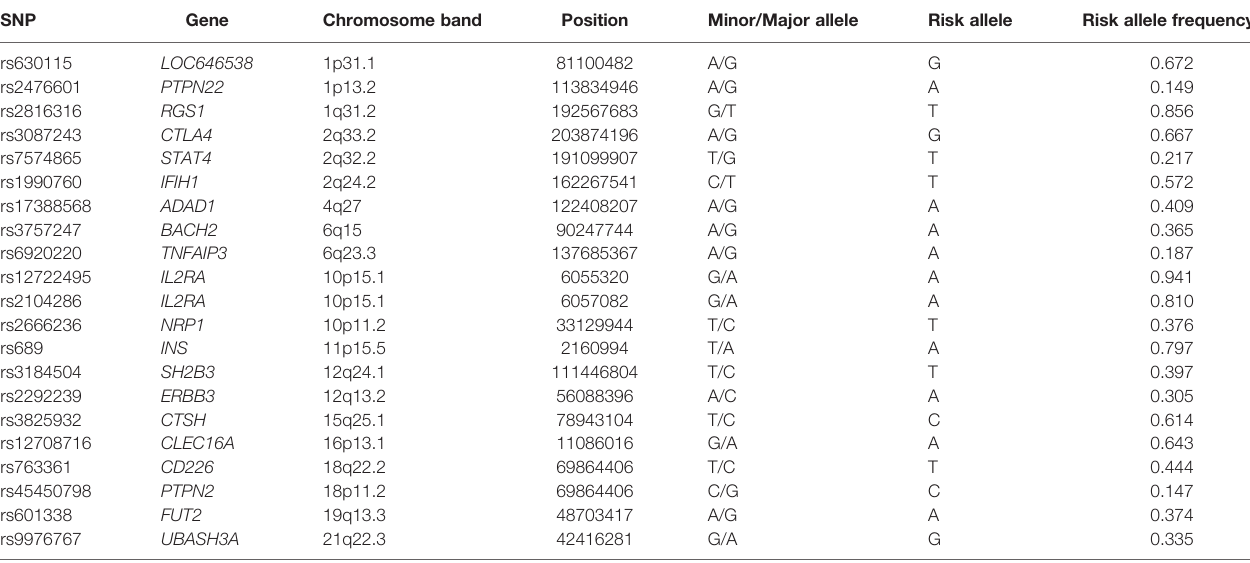
TABLE 3 | The genetic location and allele frequencies of the studied